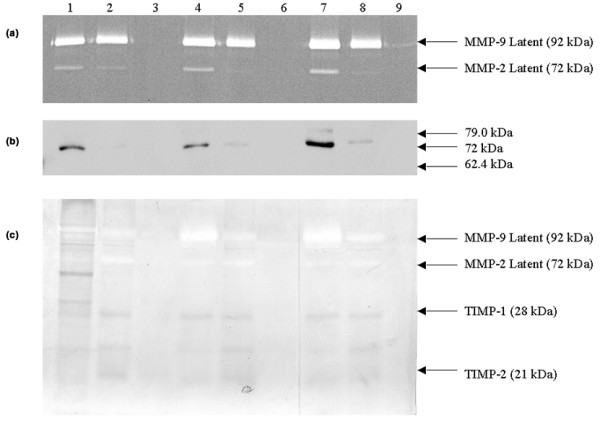
The effects of MCF-7 breast adenocarcinoma CM on MMP and TIMP activity from THP-1 monocytes. (a) Gelatin zymogram and (b) MMP-2 immunoblot showing the upregulation of monocyte MMP-2 after exposure to MCF-7 CM, and (c) a reverse zymogram to show that the activity of monocyte TIMP-1 and -2 remained the same upon treatment. Lanes 1, 4, and 7 contain CM from THP-1 cells in serum-free media grown in the presence of 100 μl, 200 μl and 300 μl concentrated MCF-7 CM, respectively. Lanes 2, 5, and 8 contain CM from THP-1 cells in serum-free media grown in the presence of 100 μl, 200 μl and 300 μl concentrated serum-free media, respectively. Lanes 3, 6, and 9 contain serum-free media with 100 μl, 200 μl and 300 μl, respectively, of MCF-7 CM in the absence of THP-1 cells. These figures are representative of three independent experiments carried out in duplicate, each of which demonstrates similar results.